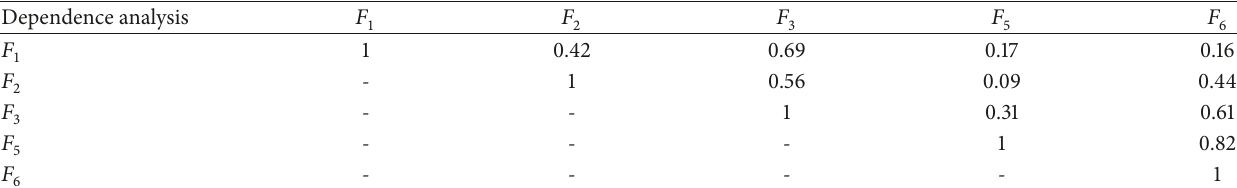
Table 4: Times of feature selections based on compressed random subspace.